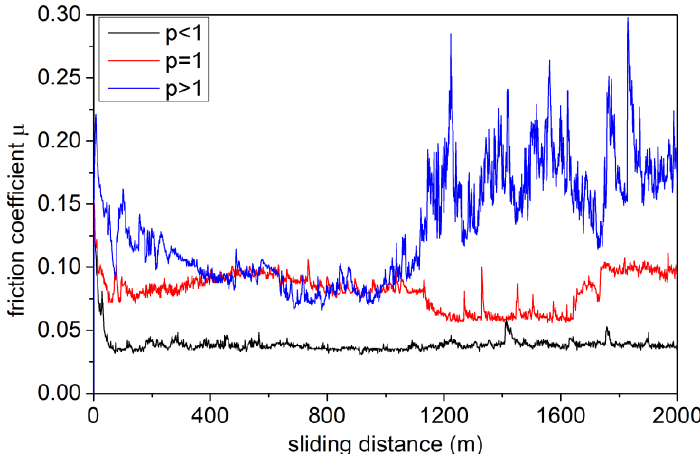
Figure 12. Coefficients of friction for selected prototypes vs. sliding distance.